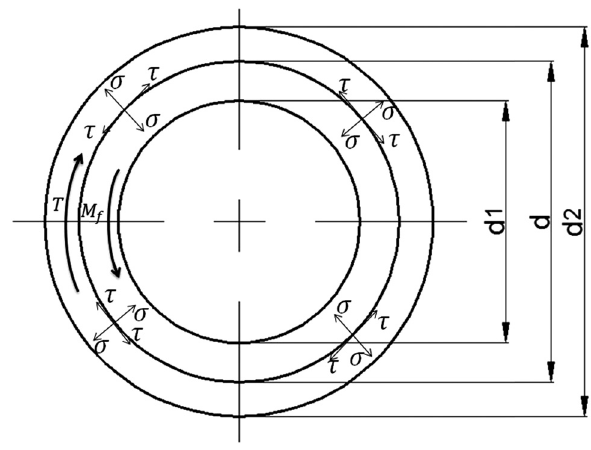
Figure 3: Cross - section of interference fi